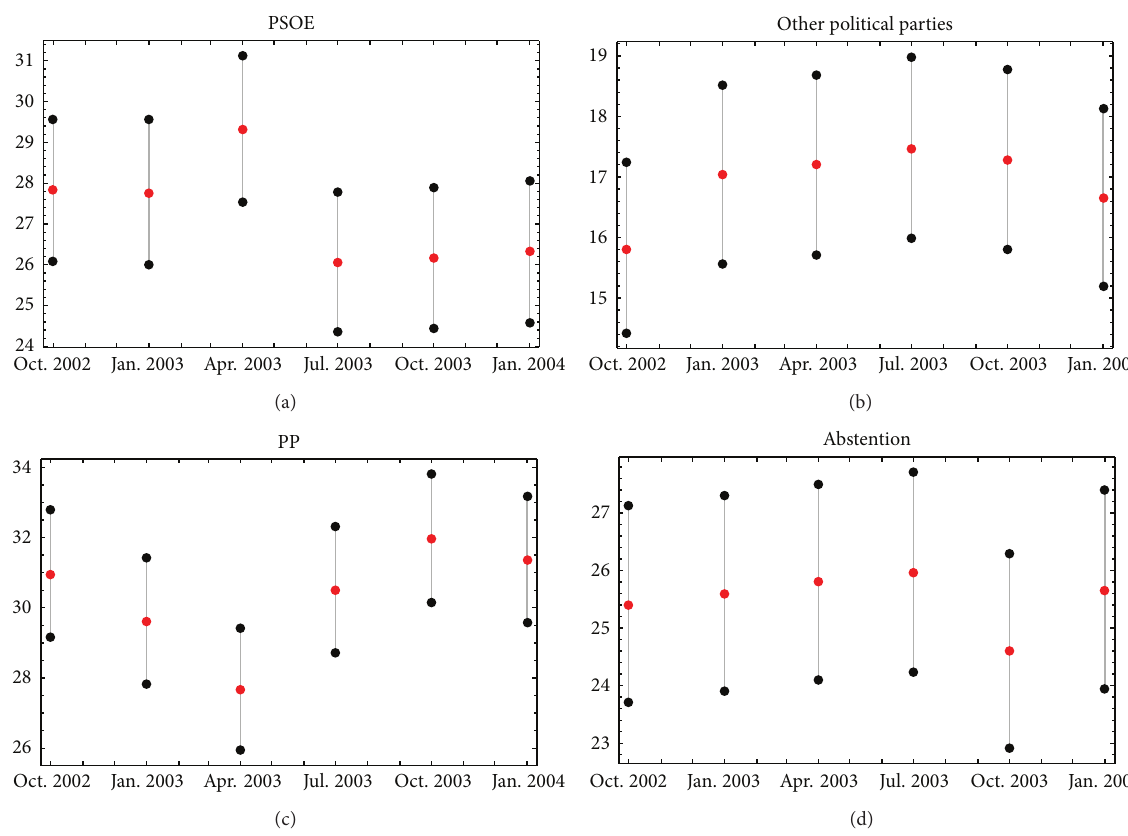
Figure 3: Percentiles 2.5 (lower black points), 97.5 (upper black points), and the mean (red points corresponding to data from Table 1) of data. The percentiles determine the 95% confidence intervals. These confidence intervals capture 95% of data uncertainty.